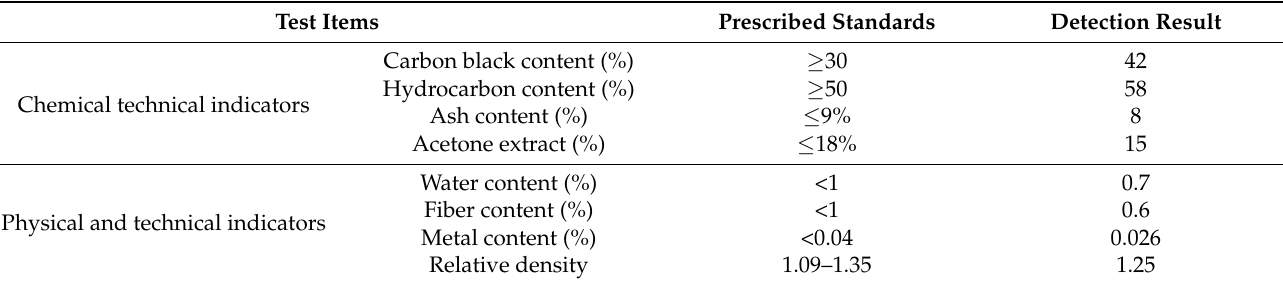
Table 2. Physical and chemical technical indexes of rubber